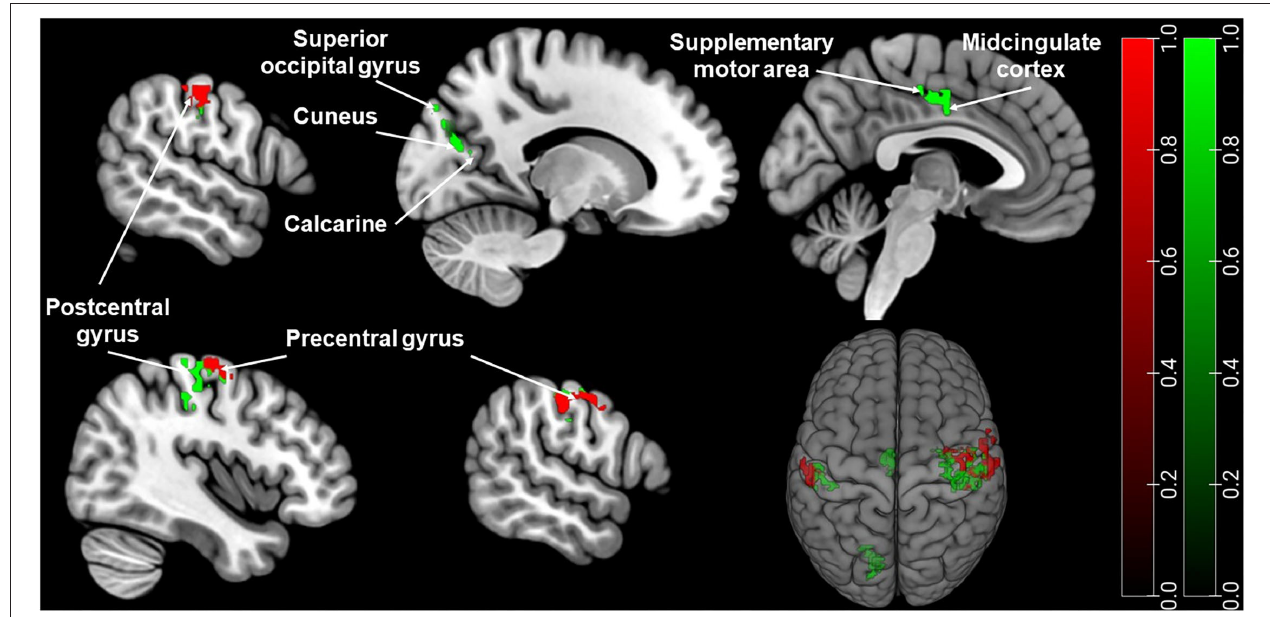
FIGURE 1 | Brain regions with significantly different PAG-FC between men and women. Green: right PAG connectivity, Red: left PAG connectivity. The significance threshold was set at cluster-level p FWE < 0.05. Coordinates are in Montreal Neurological Institute (MNI) space. For visualisation, the thresholded statistical map generated by SPM was added as an overlay image on the MNI152 brain template image in MRIcroGL (http://www.mccauslandcenter.sc.edu/mricrogl/) (